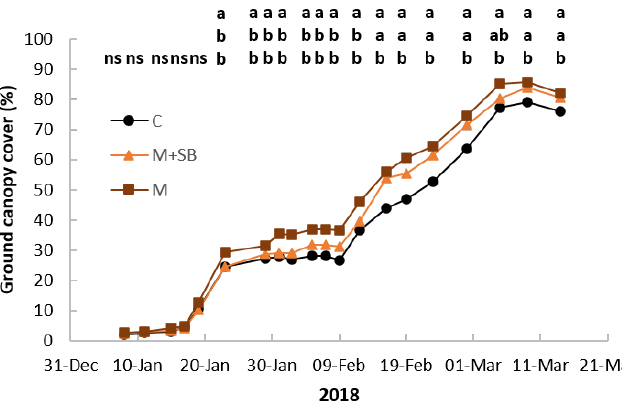
Figure 8. Average percentage of canopy ground cover (GCC) in the treatments assessed in experiment 3: unamended (C), manure (M) and manure plus rice straw banded (M + SB). Different letters within a measurement date indicate statistically significant differences ( p < 0.05) between treatments. The order of the letters from top to bottom correspond with the order in which treatments are presented in the legend. “ns” denotes not statistically significant differences. Table 6. Average aboveground biomass (t ha − 1 ) at the vegetative (30 January 2018), flowering (12 February 2018), pod development (21 March 2018) and maturity (4 April 2018) stage for the control (C), manure (M) and manure plus rice straw (M + SB) amendment treatments tested in the 2017/18 dry season.